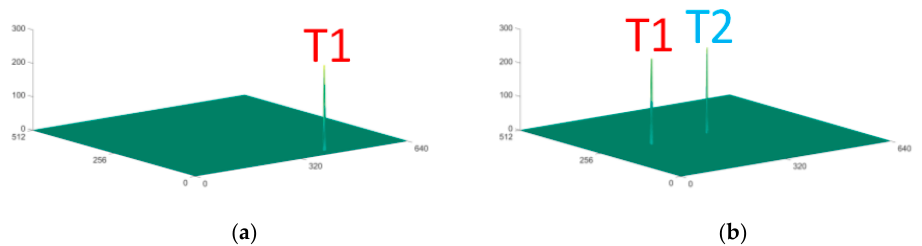
Figure 12. Binary segmentation results of images A and B. ( a ) Image A segmentation result. ( b ) Image B segmentation result.